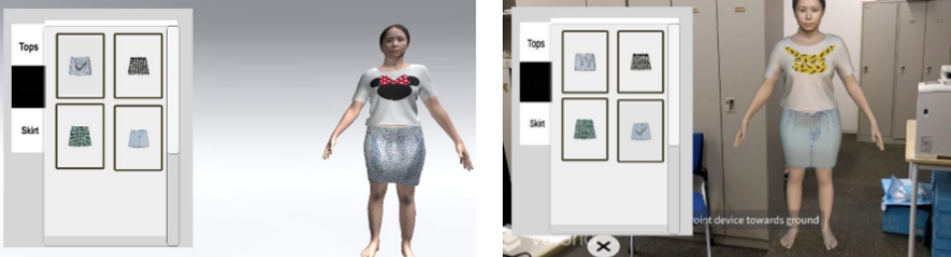
Figure 5. 3D virtual try-on interface: VR-based try-on ( left ) and AR-based try-on ( right